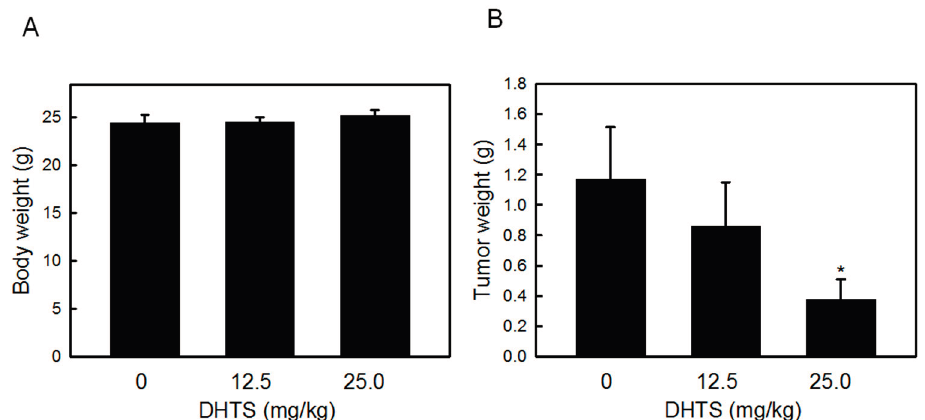
Figure 6. Effects of 15,16-dihydrotanshinone I (DHTS) on HL-60 tumor xenografts in nude mice. HL-60 cells were subcutaneously injected between the scapulas of athymic nude mice, and the mice received an i.p. injection of 12.5 or 25 mg/kg DHTS a day for a week. ( A ) Body weight and ( B ) tumor weight were measured at the end of the experiment. Values were obtained in five samples and are presented as the mean ± S.D. * p < 0.05